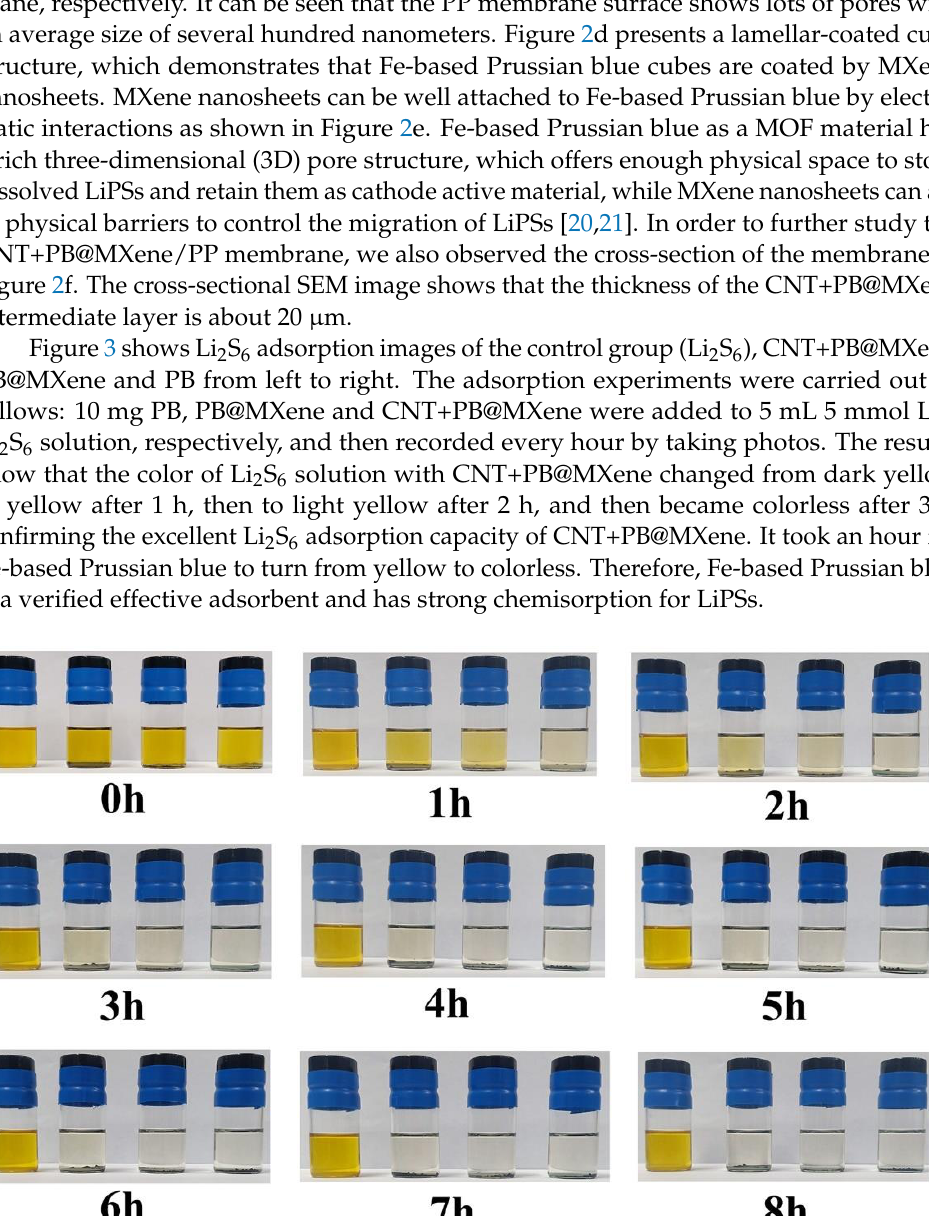
Figure 2c,d are the SEM images of the PP membrane and CNT+PB@MXene/PP mem-